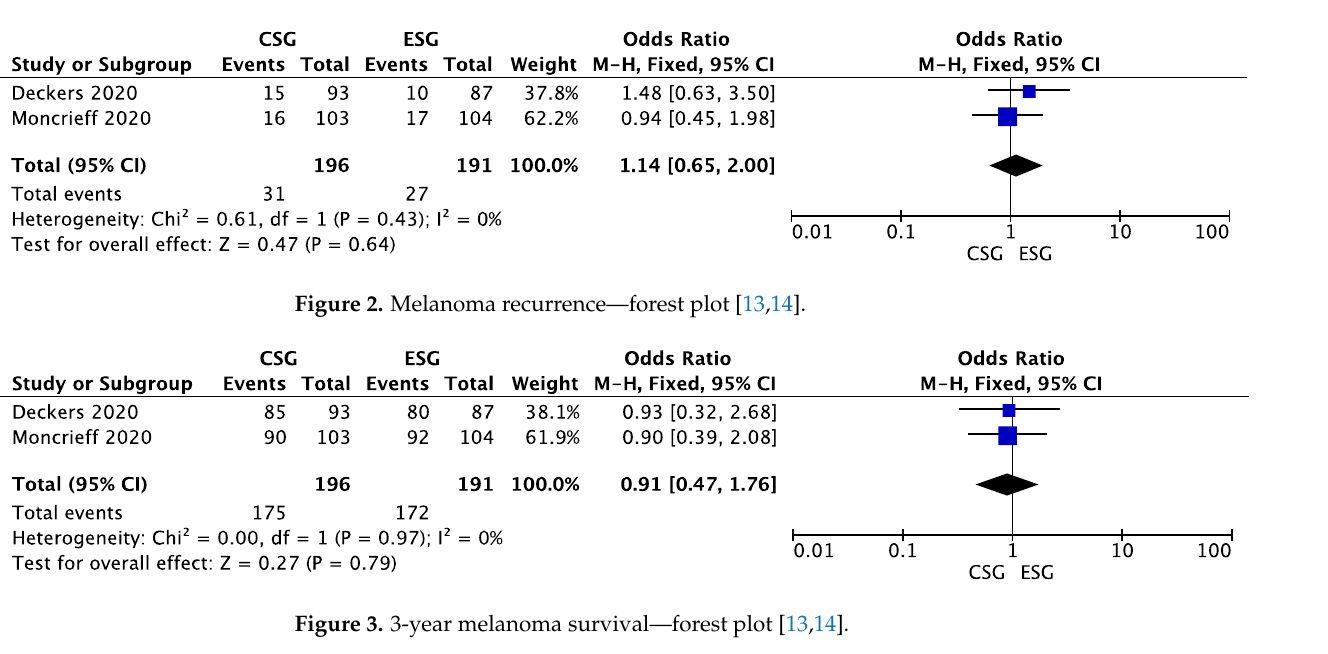
Figure 3. 3-year melanoma survival—forest plot.